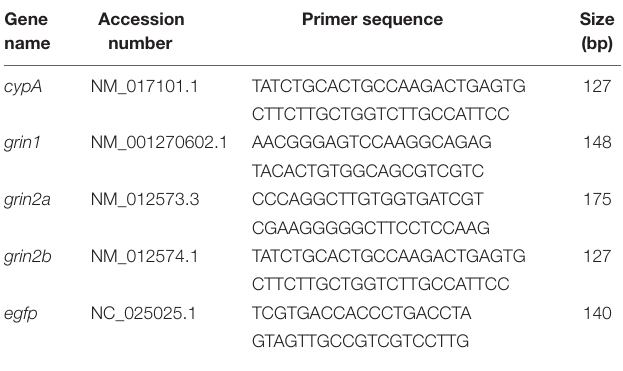
15 min. Reactions were stopped by heating at 80 ◦ C for 5 min and cooling on ice. Each reverse-transcribed product was diluted with RNAse-free water to a final volume of 60 µ L and stored at − 20 ◦ C for further use. cDNA amplification was performed using 5 µ L of the obtained cDNA, 10 pmol of each primer (Invitrogen Argentina), and TABLE 1 | Sequences and bp of the selected